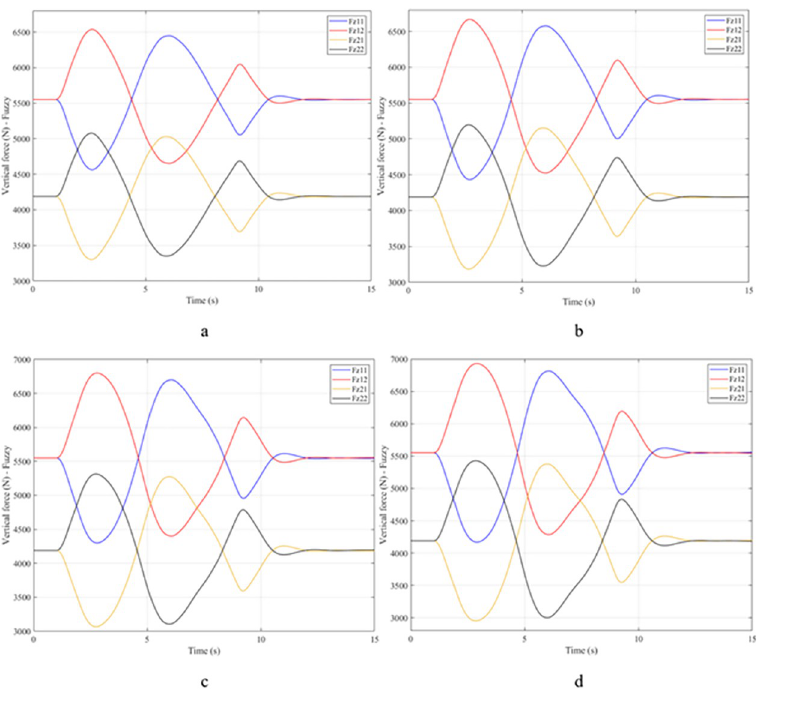
Fig 16. Vertical